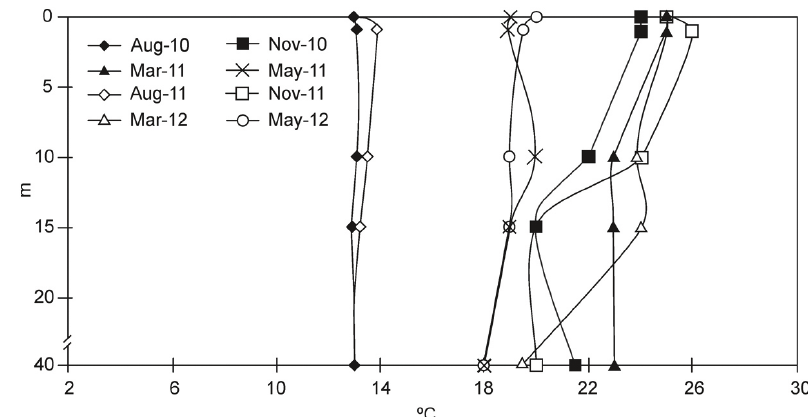
Figure 4. Thermal profile of the limnetic zone of the